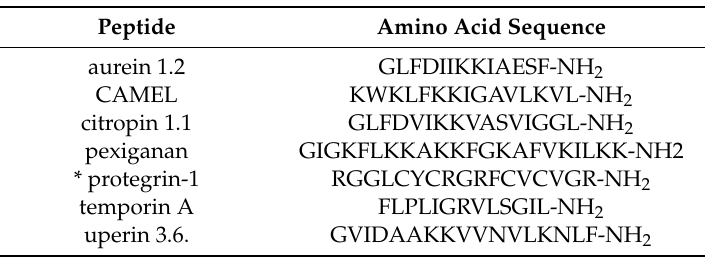
Table 1. Amino acid sequences of tested antimicrobial peptides. Peptide Amino Acid Sequence aurein 1.2 GLFDIIKKIAESF-NH 2